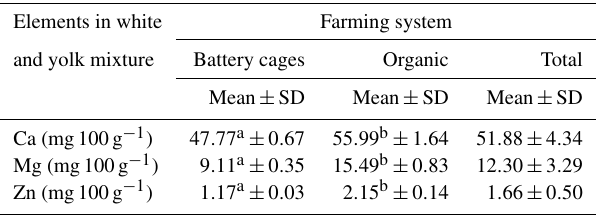
Table 3. Content of Ca, Mg and Zn in the mixture of egg yolk and white depending on the farming